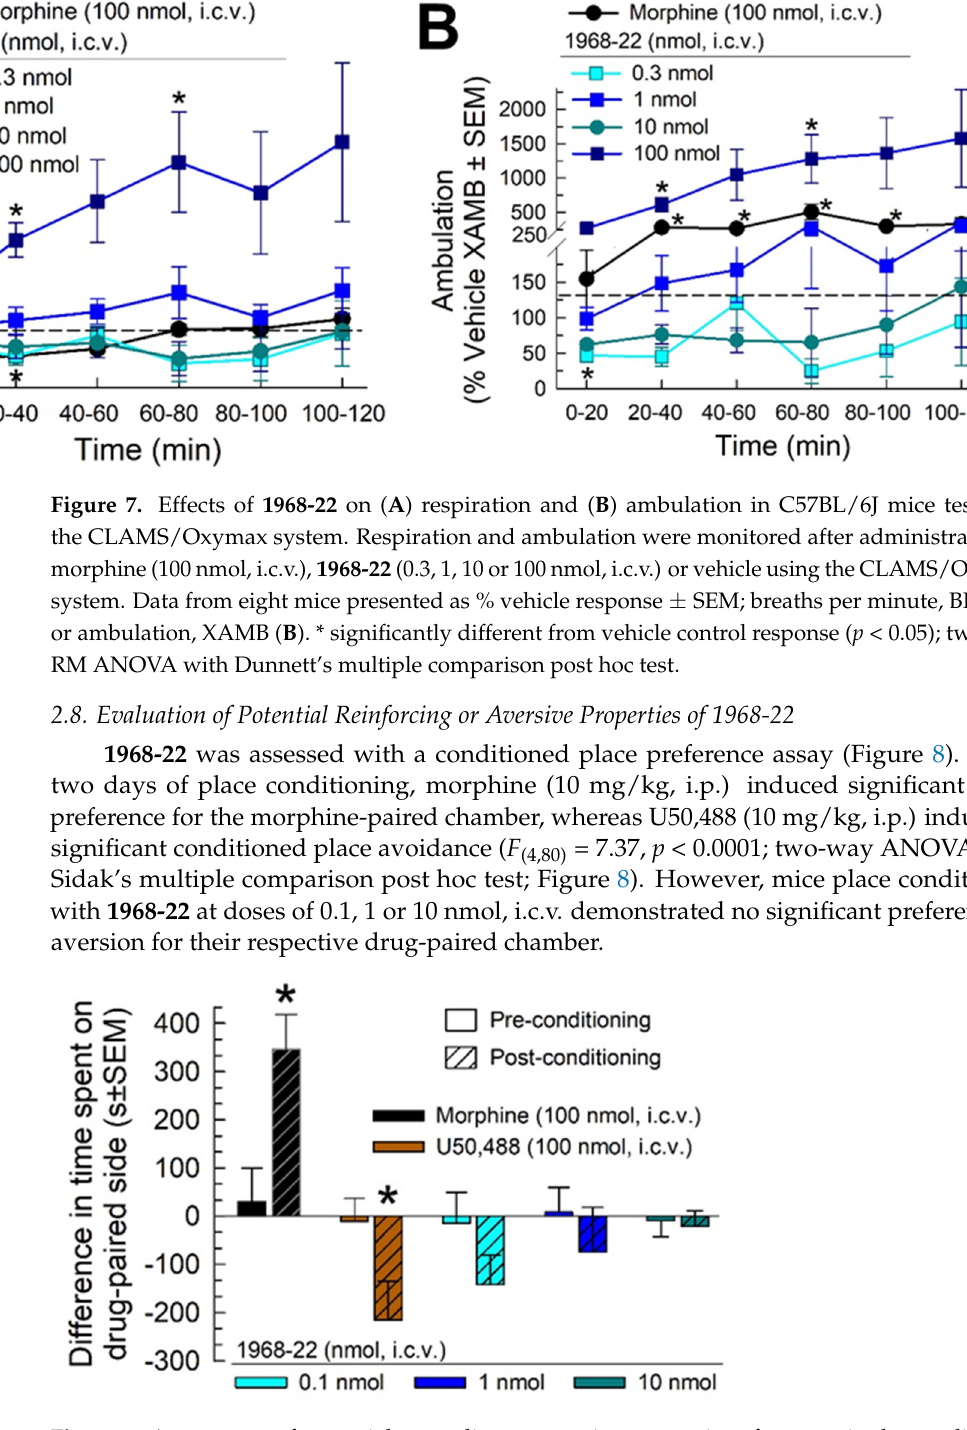
Figure 8. Assessment of potential rewarding or aversive properties of 1968-22 in the conditioned place preference test. Counterbalanced place conditioning of C57BL/6J mice was performed daily for two days with morphine or U50,488 (100 nmol, i.c.v., each), or 1968-22 (0.1, 1 or 10 nmol, i.c.v.). Data are presented as mean difference in time spent on the drug-paired side ± SEM, with positive and negative values indicating a preference for and avoidance of the drug-paired chamber, respectively. The left bar in each pair is the pre-conditioning response, and the right (striped) bar in each pair is the post-conditioning response. * Significantly different from matching pre-conditioning preference ( p < 0.05), two-way ANOVA. n = 15–22